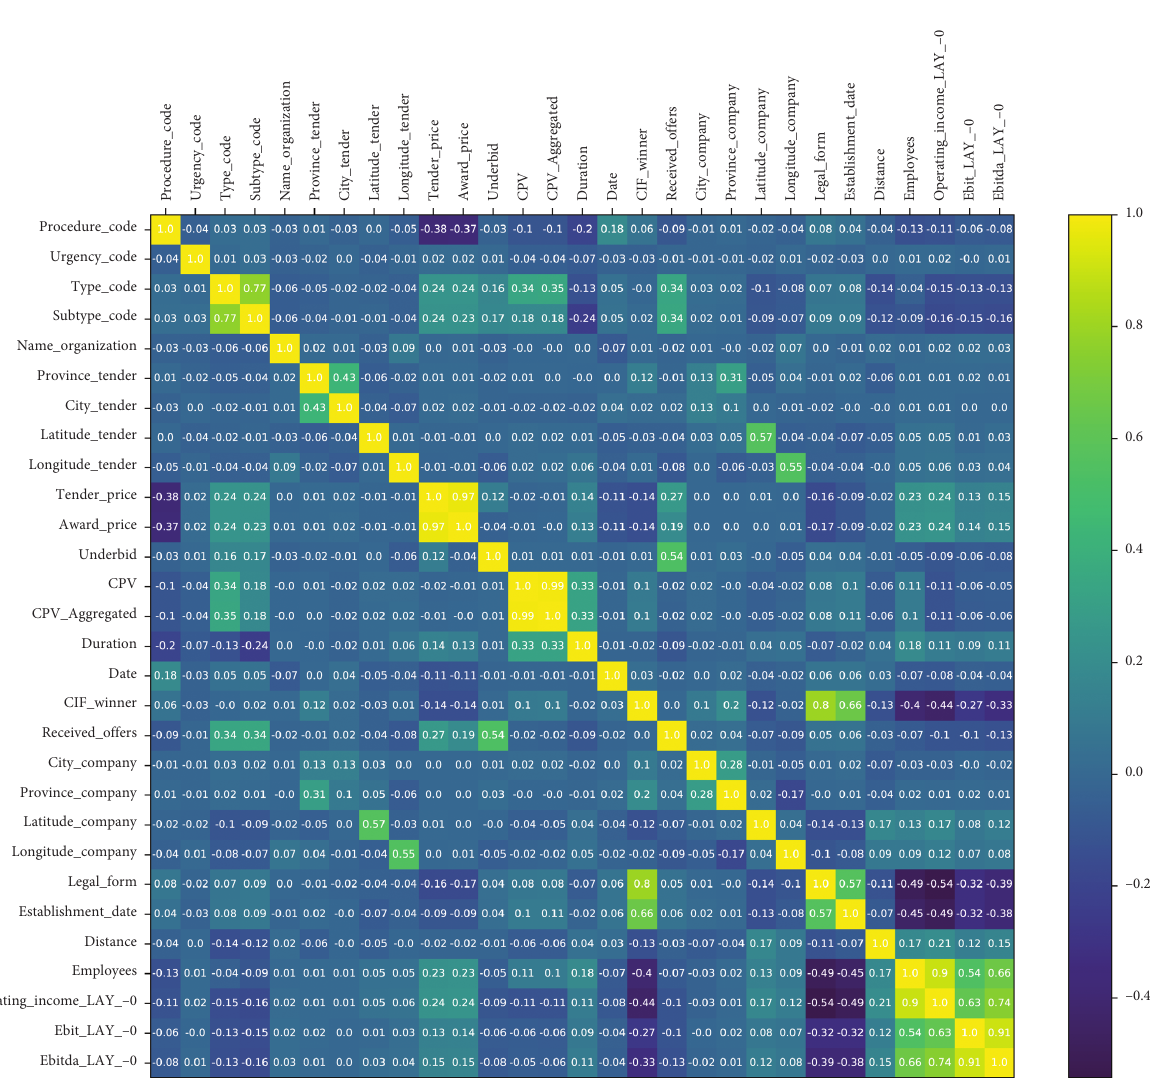
Figure 5: Correlation matrix between the variables of the two datasets (tenders and companies). Spearman’s rank correlation coefficient is the method